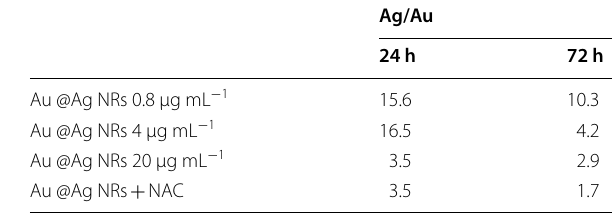
Table 2 Intracellular levels of Au and Ag Table 3 Weight ratio of